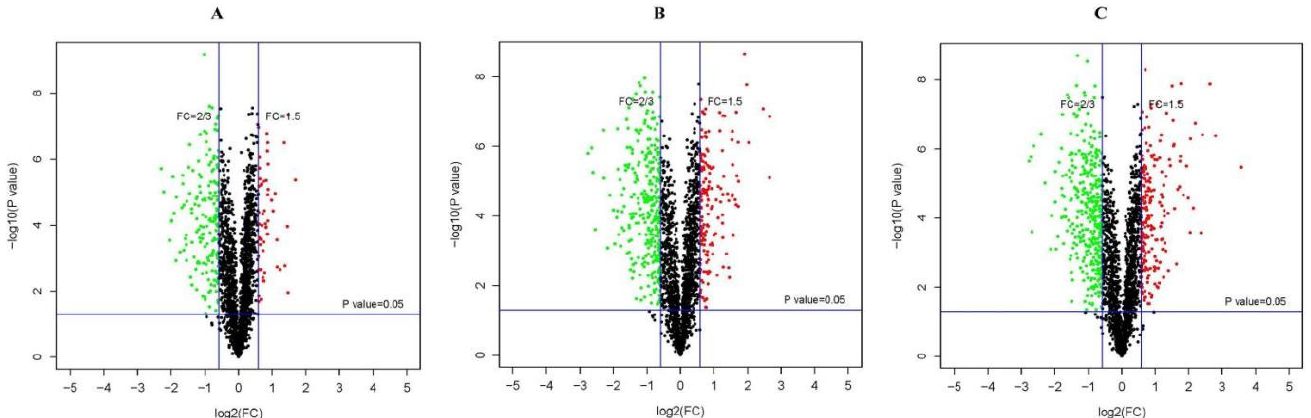
Figure 2. ( A – C ) Volcano plots showing DEPs in V. volvacea S24–S0, S60–S0, and S96–S0. Dots highlighted in red (FC ≥ 1.5) and green (FC ≤ 2/3) indicate proteins that exhibited significantly different expression levels ( p ≤ 0.05).